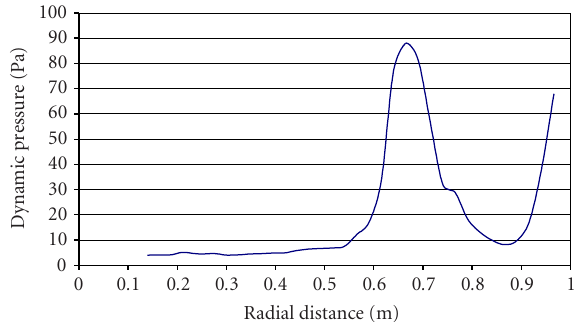
Figure 3: Dynamic pressure as a function of radial distance along the fan blade.